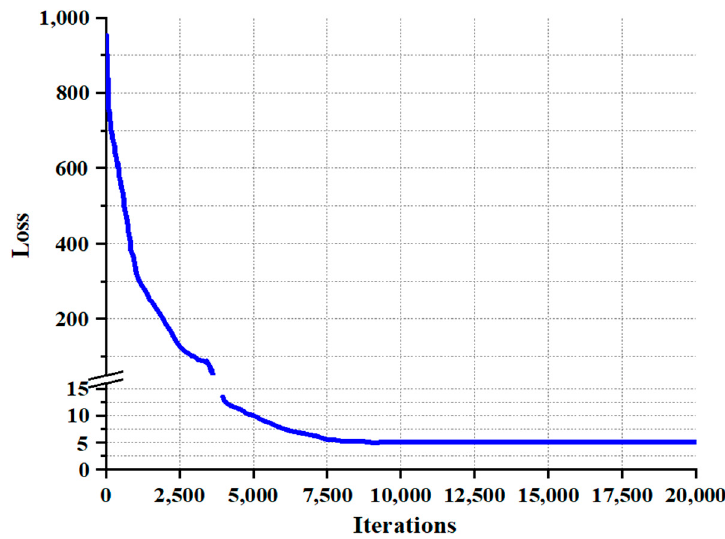
Figure 6. The training loss function diagram of the improved model on the dataset.